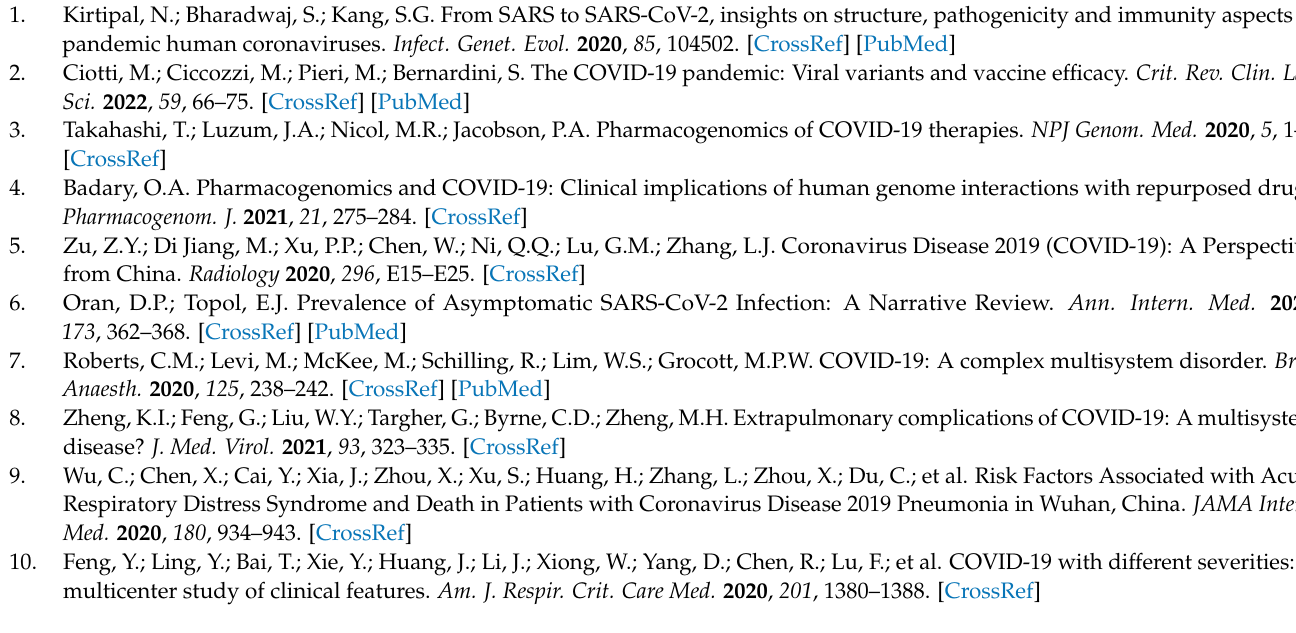
ods; Supplementary Table S1: Genes identified in GWAS studies in COVID-19; Supplementary Table S2: Output of the pathway enrichment analysis for the GO biological process; Supplementary Table S3: Output of the pathway enrichment analysis using the Kyoto Encyclopedia of Genes and Genomes database; Supplementary Table S4: Output of the pathway enrichment analysis for the Reactome database; Supplementary Table S5: Identified registered clinical trials on antioxidants in COVID-19; Supplementary Table S6: Identified registered clinical trials on GSH or NAC supplemen- tation in COVID-19. References [243–251] are cited in the supplementary